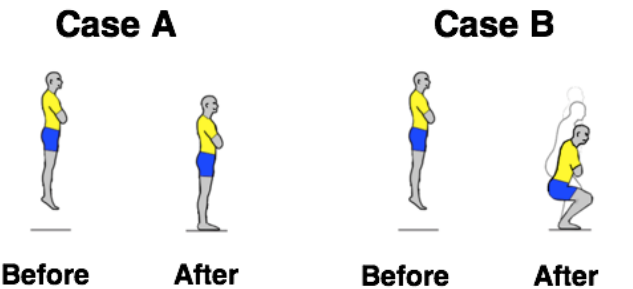
Fig. 3 Schematic diagram of the simulation of a human body landing from the toe touching the ground to the foot lying